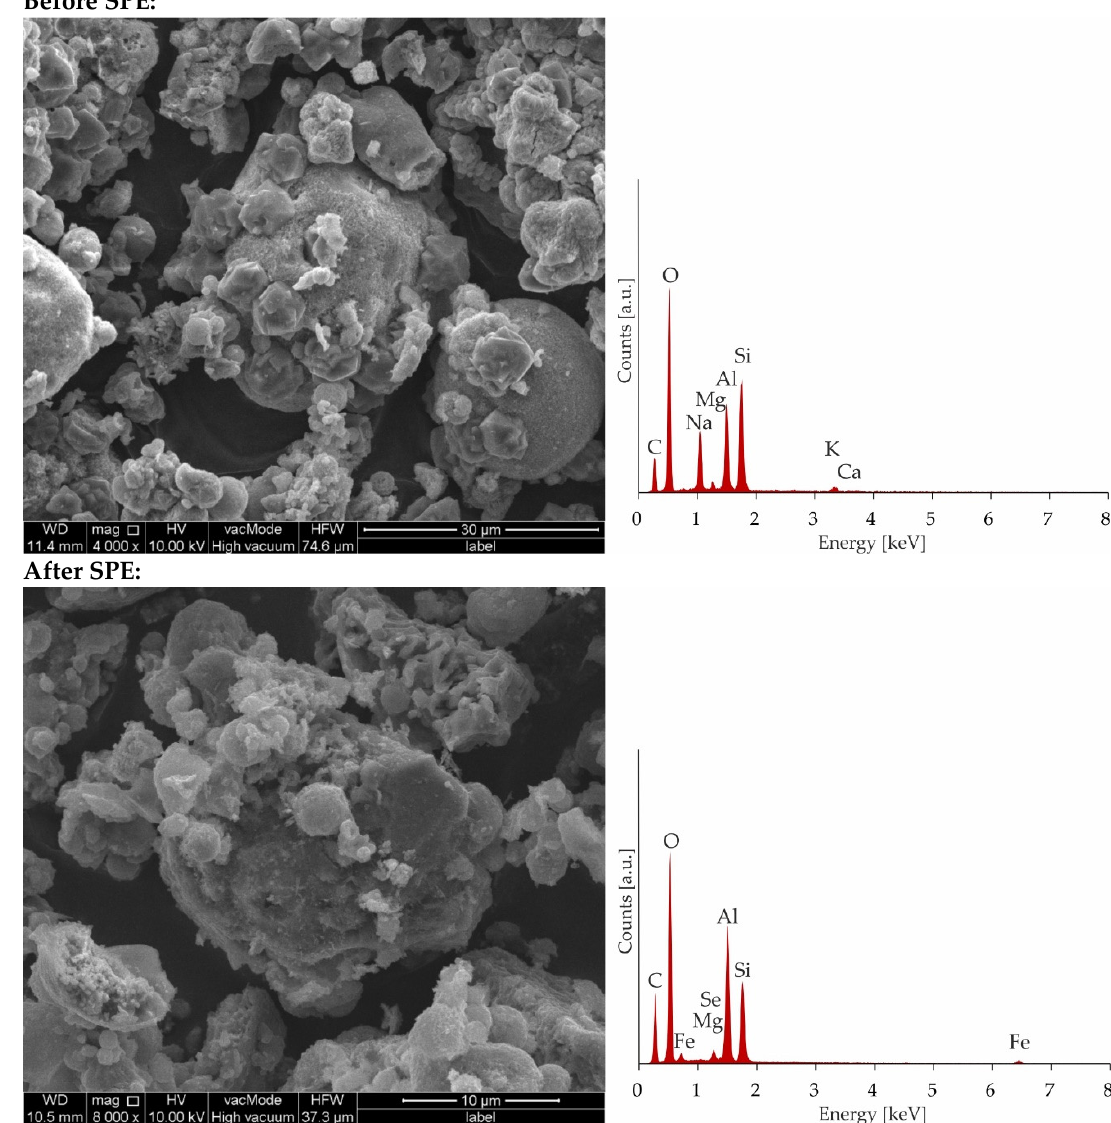
Figure 8. Microphotographs and EDS charts of zeolite Na-X before and after SPE.